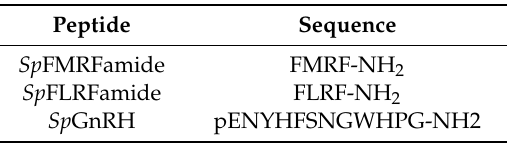
Table 2. Peptides used in the present